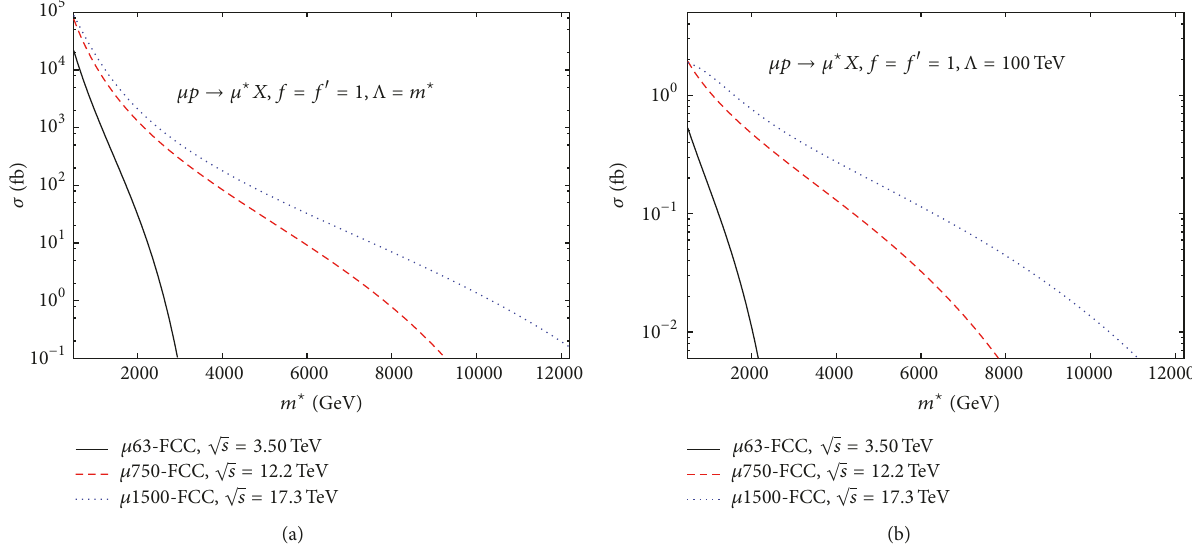
Figure 3: Total cross-section as a function of the excited muon mass for the 𝜇𝑝 colliders with various center-of-mass energies for Λ = 𝑚 ∗ (a) and Λ = 100 TeV (b),